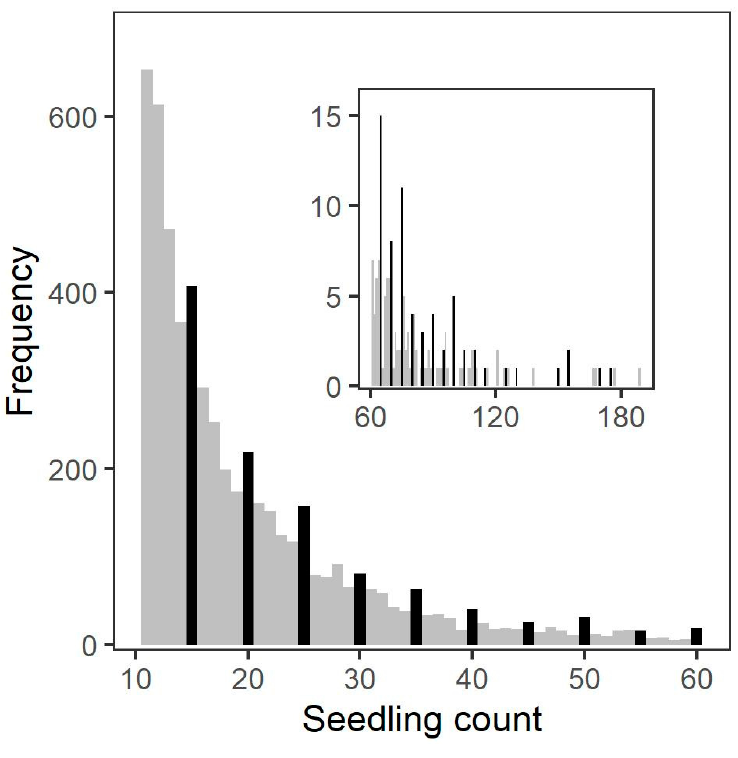
Figure 5. Distribution of seedling counts >10. Darkest bars indicate counts ending with the digit zero or five. Table 5. Estimated coefficients (and standard errors) for the model logit ( π ) = α + β 1 x 1 + β 2 x 2 + · · · + β 14 x 14 predicting the probability that seedling count ends with the digit 0 or 5 by